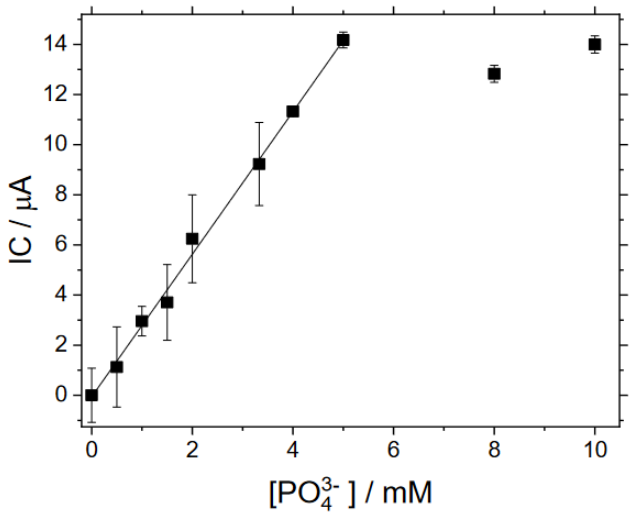
Figure 5. Calibration curve for the determination of phosphate obtained for the ALP@AETAC-modified electrochemical biosensor. The value of the coefficient of determination of the linear zone is R 2 = 0.9993.